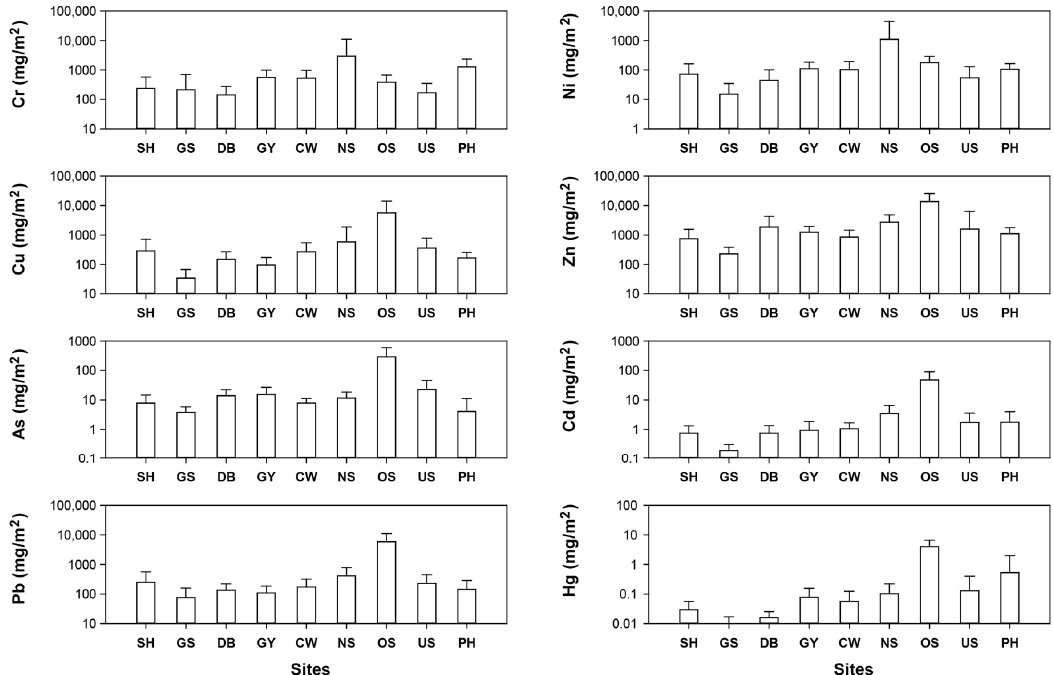
Figure 4. Comparison of median potentially toxic elements (PTEs) load (mg/m 2 ) in RD samples from different industrial areas in this study. Log-scale was used for arithmetic scaling of the y-axis. Values are expressed as median ± standard deviation (SD) of the measured metal data.